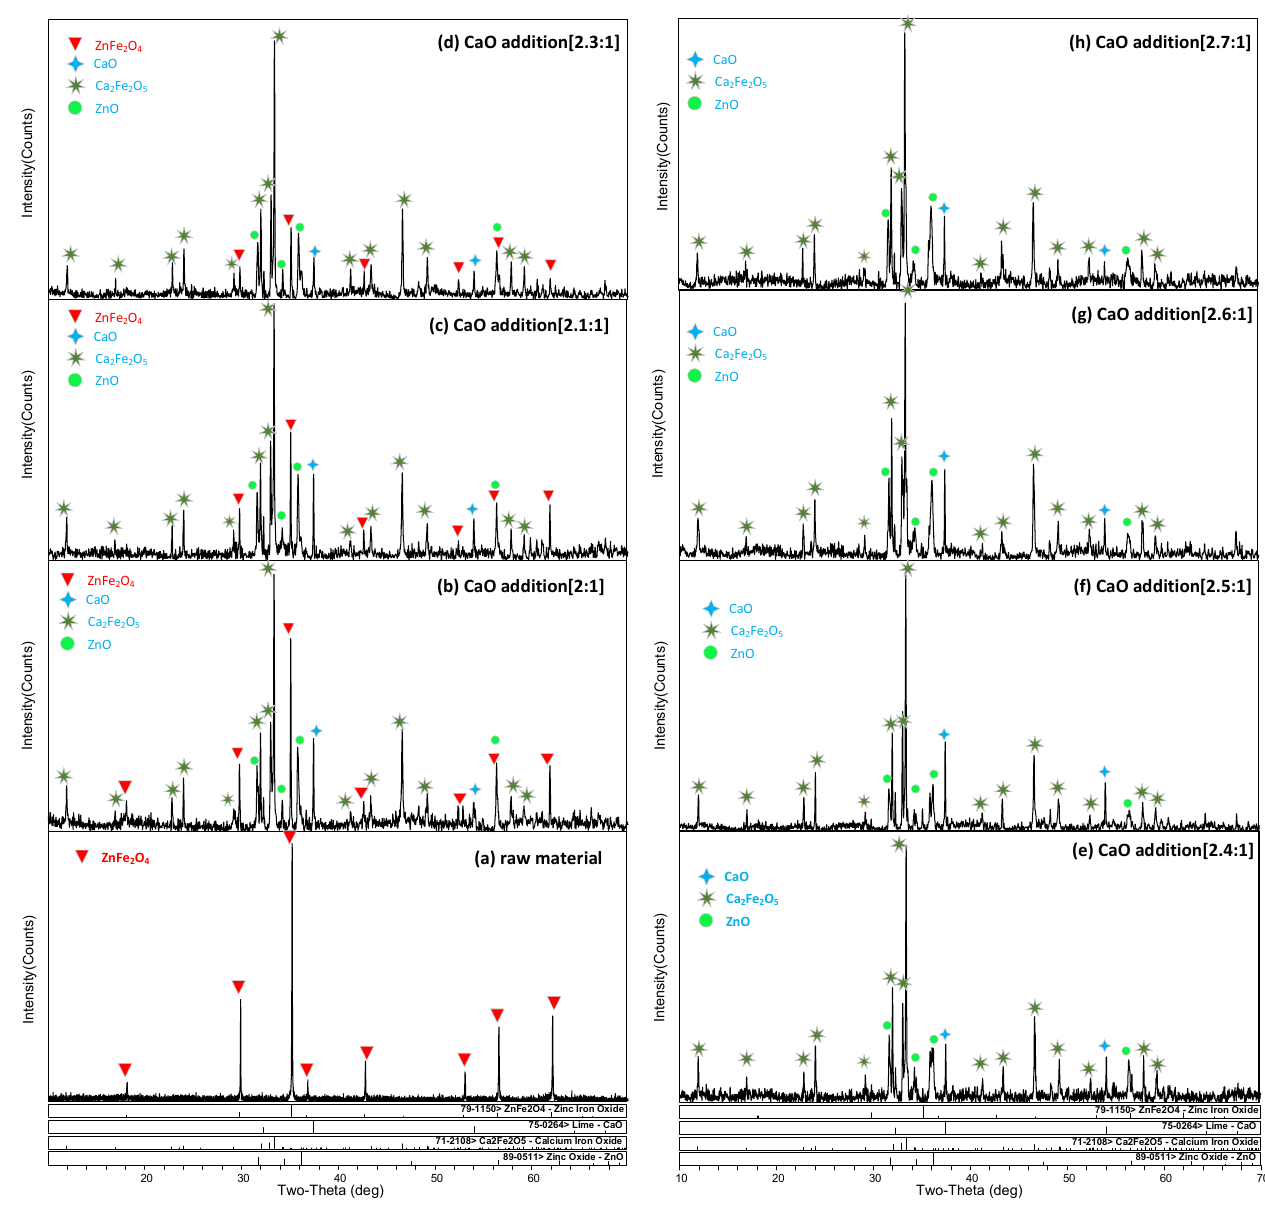
Figure 4. XRD patterns of roasted samples with various CaO addition: ( a ) raw material, ( b ) CaO addition of 2.0:1, ( c ) CaO addition of 2.1:1, ( d ) CaO addition of 2.3:1, ( e ) CaO addition of 2.4:1, ( f ) CaO addition of 2.5:1, ( g ) CaO addition of 2.6:1, ( h ) CaO addition of 2.7:1.